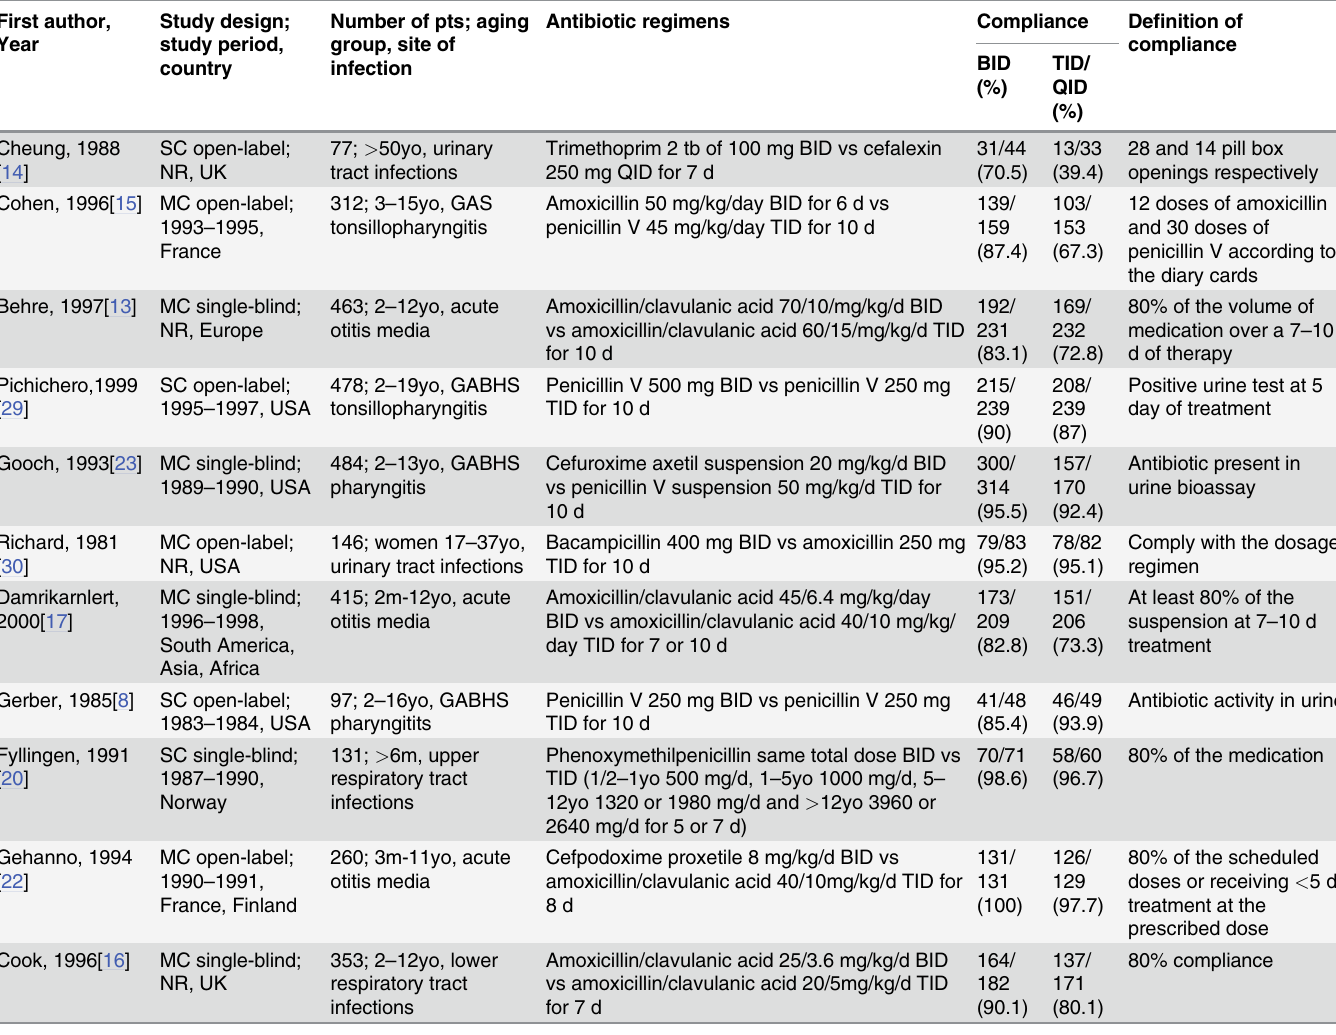
Table 2. Characteristics and outcomes of the studies comparing compliance with twice versus /thrice/four times daily antibiotic